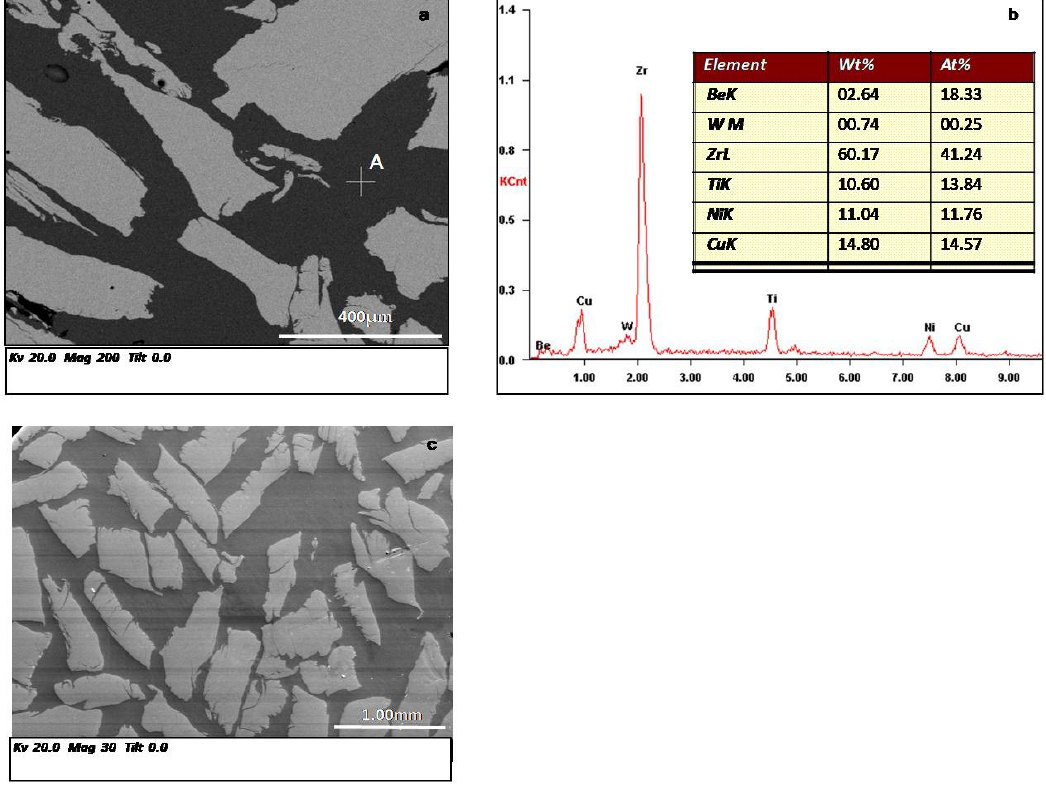
Figure 2. SEM micrograph ( a , c ) and energy dispersive spectroscopy (EDS) spectrum ( b ) of the W particles/Zr 41.2 Ti 13.8 Cu 12.5 Ni 10 Be 22.5 metallic glass matrix composite.